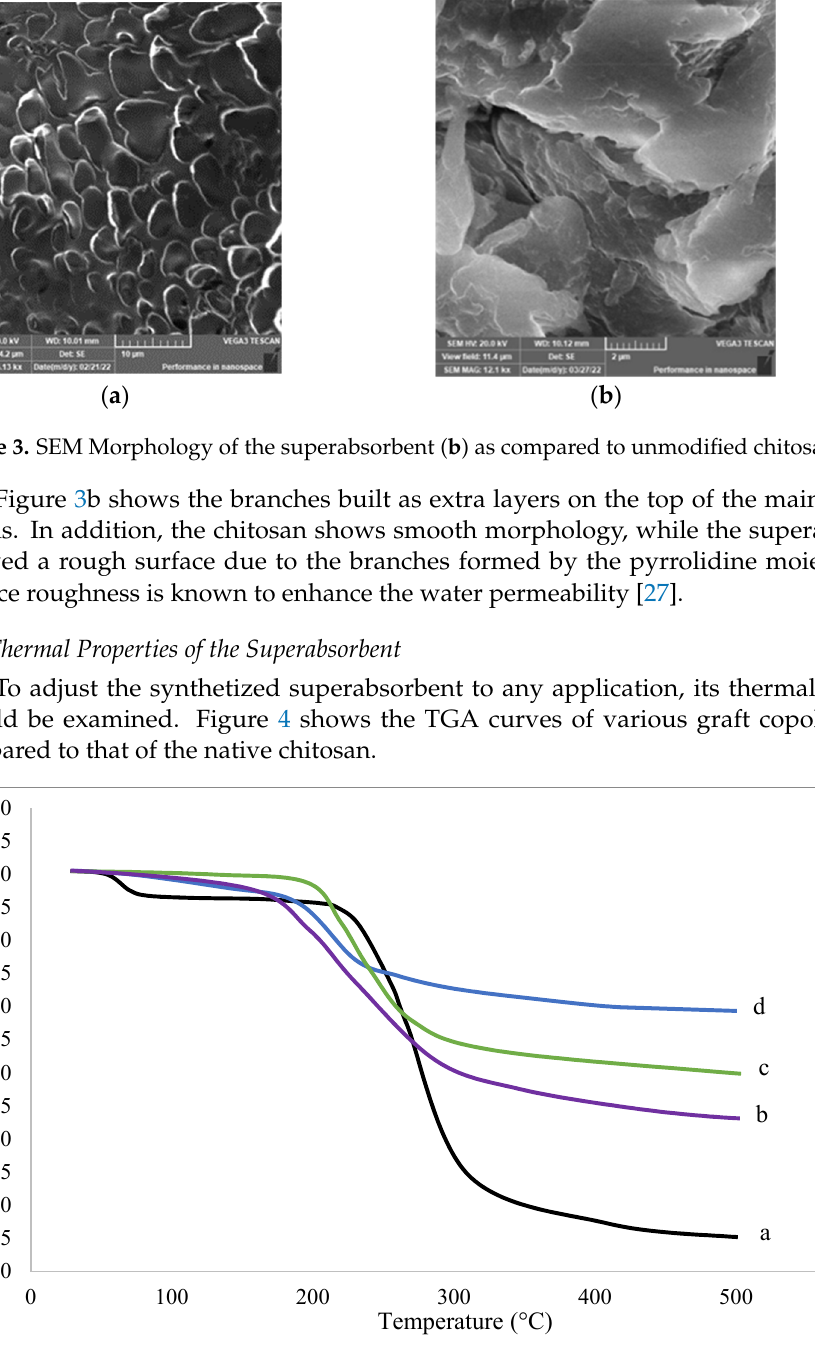
Figure 2. 13 C-NMR spectrum of SA.